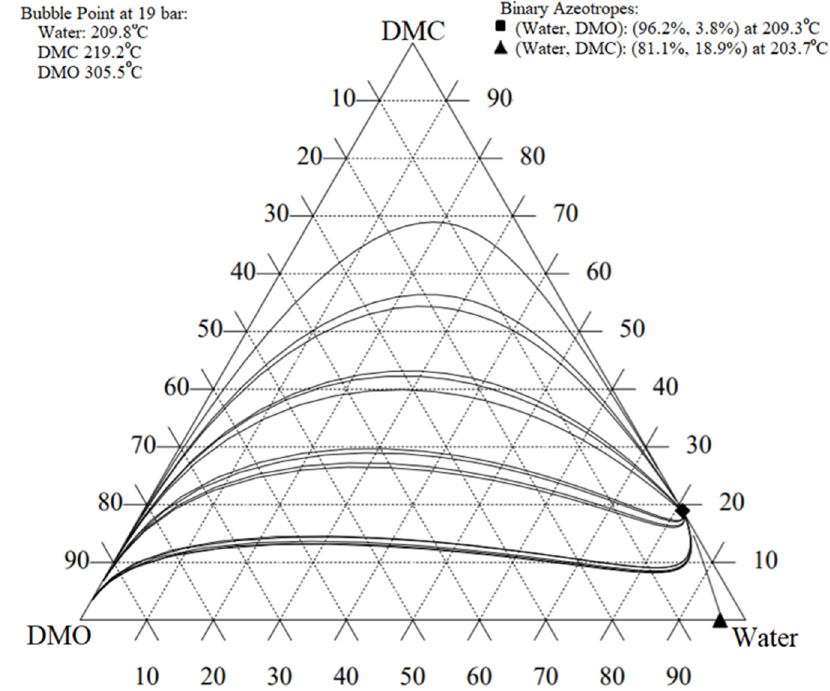
Figure 1. Ternary diagram showing the DMC-H 2 O and DMO-H 2 O azeotropes, along with the residue-curve map, for the distillation from the azeotropic points. The UNIFAC method was used for this calculation.